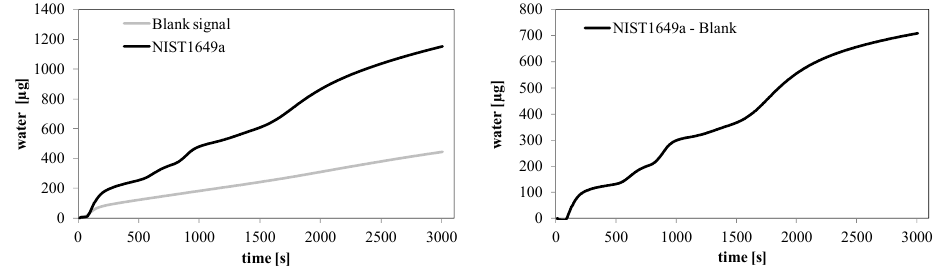
Fig. 1. Karl-Fisher analysis of the reference material NIST1649a. Left panel: original sample signal and blank signal. Right panel: sample signal after blank